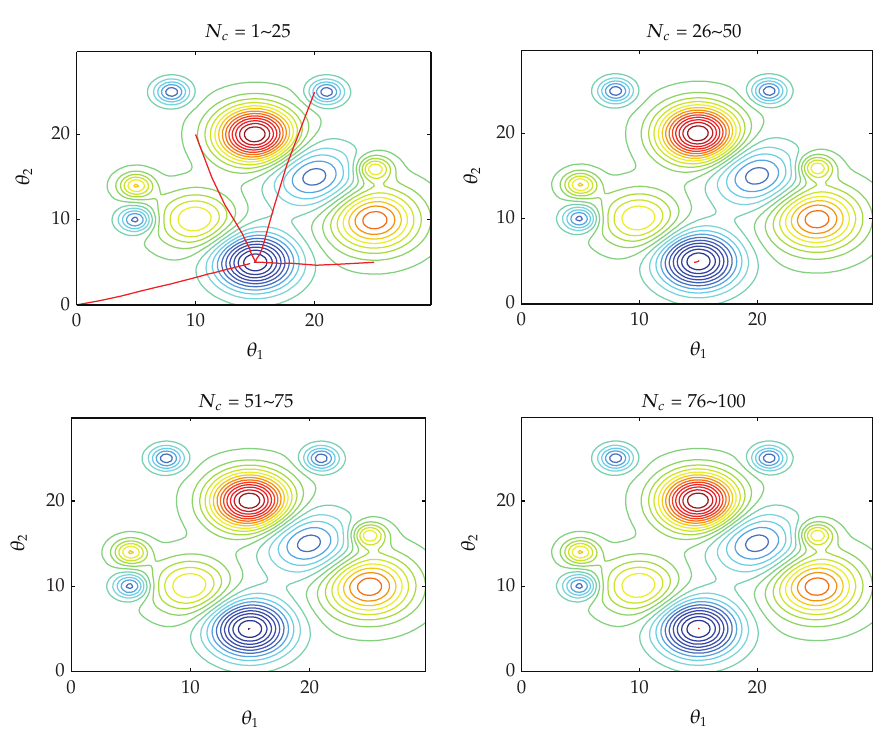
Figure 13: Four bacteria find the optimum when chemotaxis ranges between 1 ∼ 100.